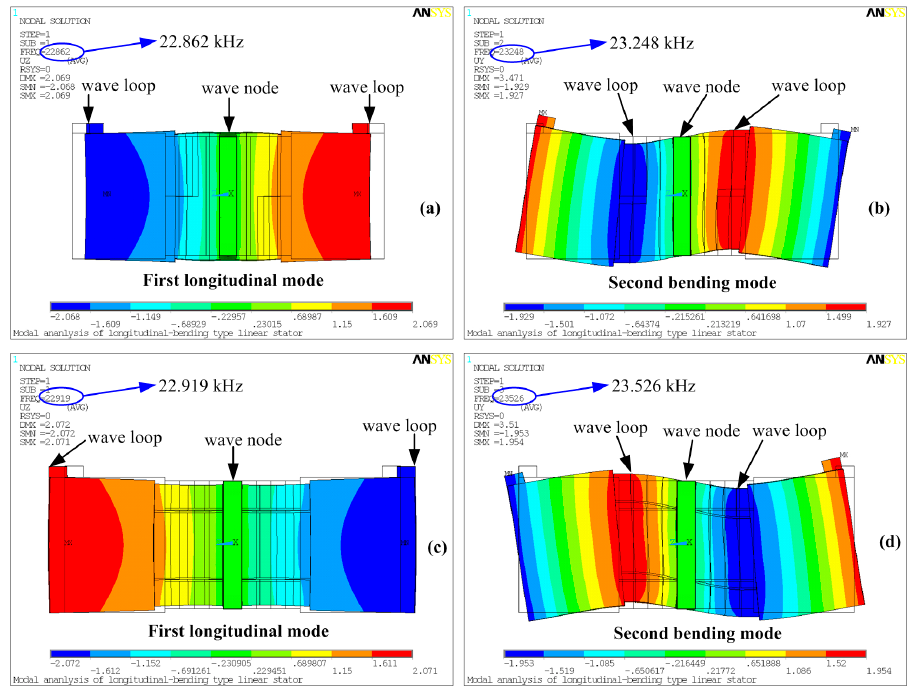
Figure 3. Vibration shapes and resonance frequencies of the transducer under different exciting methods: ( a ) first longitudinal mode under the traditional exciting method; ( b ) second bending mode under the traditional method; ( c ) first longitudinal mode under the new exciting method; ( d ) second bending mode under the new method.